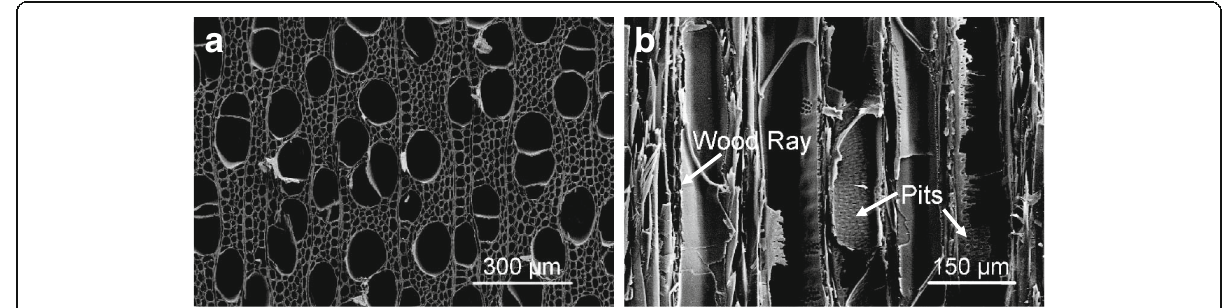
Fig. 1 Microstructure of poplar wood. a Cross section. b Longitudinal section